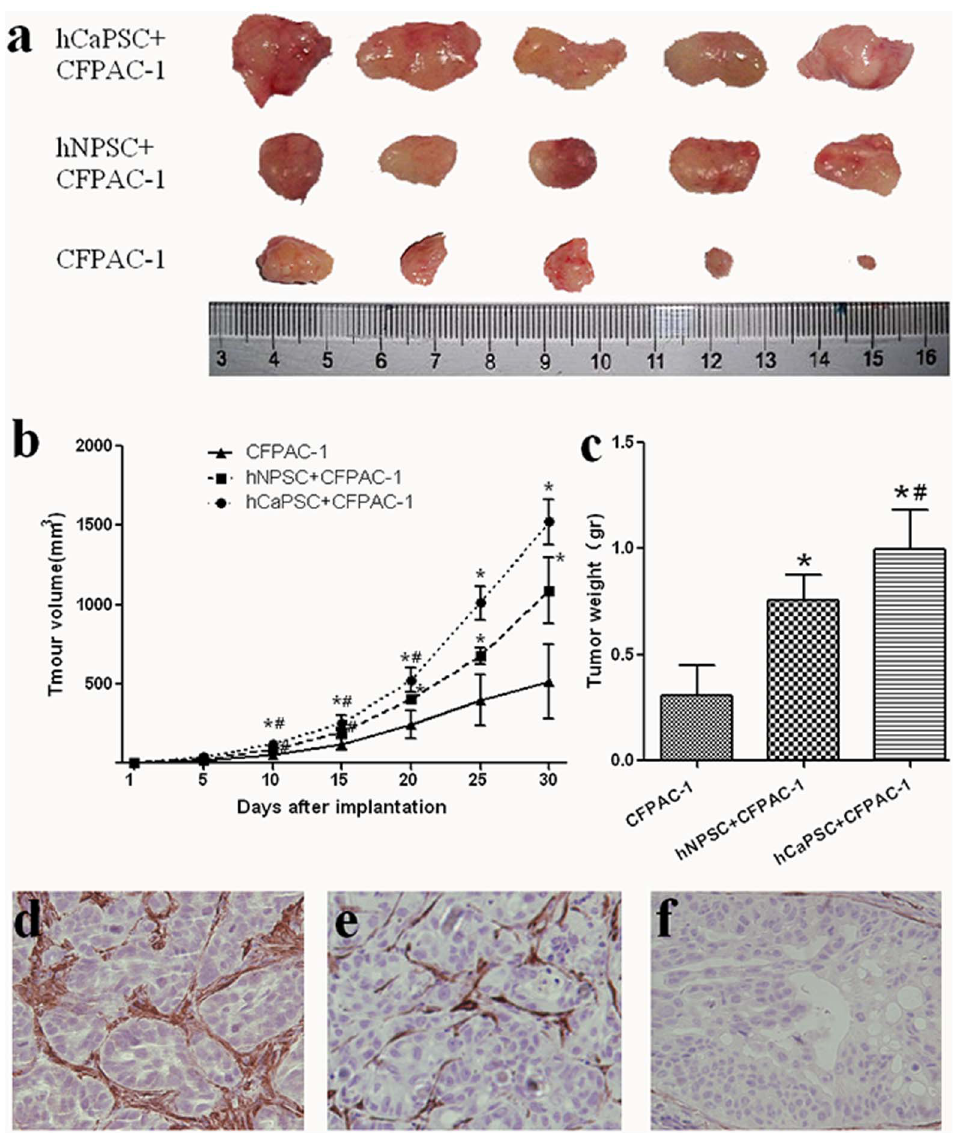
Figure 6. Effect of PSCs derived Galectin-1 on tumor establishment and growth. (a) CFPAC-1 with or without hCaPSC, hNPSC was implanted subcutaneously on both flanks of nude mice (n=5), and the mice were sacrificed and xenografts were take out on day 30 after cell implantation. Tumor volume (b) and weight (c) is expressed as the mean 6 SE. *p , 0.01 vs. CFPAC-1, # p , 0.05 vs. hNPSC + CFPAC-1. Immunohistochemisty staining of Galectin-1 in the xenografts were performed in the group of hCaPSC + CFPAC-1(d), hNPSC + CFPAC-1(e) and CFPAC-1(f). Original magnification: 6 200.